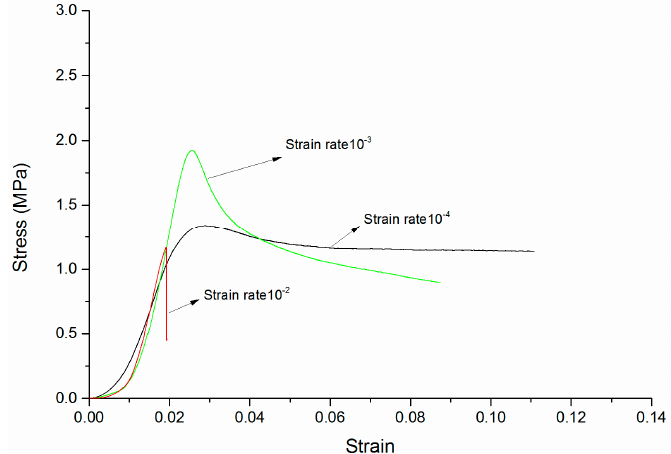
Figure 12. Sea ice load curves under different strain rates.